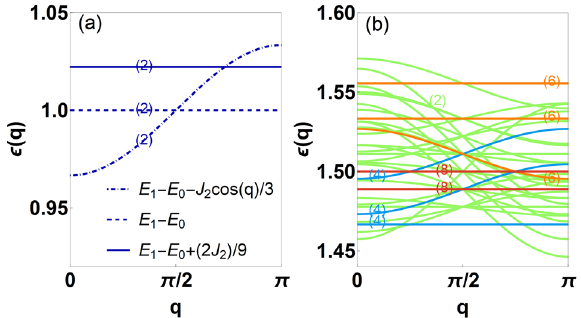
Fig. 5 Dispersion relations of the intermediate-energy and high- energy excitations in the reduced BZ. All results are from the case where g = 0.1. The numbers marked on curves represent the degeneracies. In a each dispersion relation is two-fold degenerate. In b four colors have been used to distinguish the different